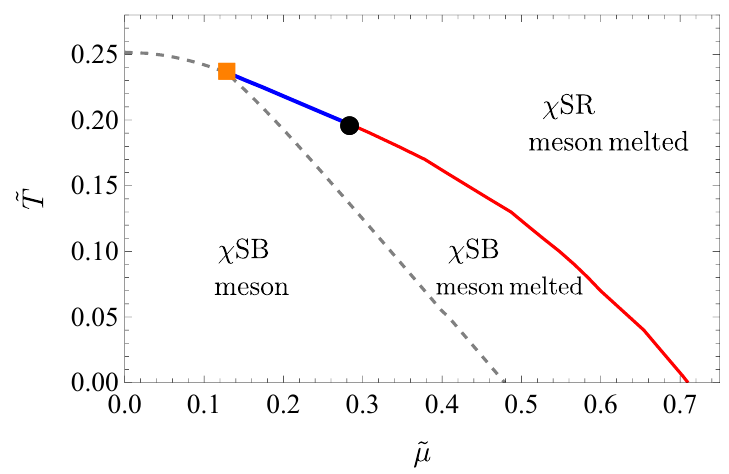
Figure 2 . The phase diagram for ˜ m = 0 . The black filled circle and orange filled square denote the TCP associated with the chiral phase transition and the critical point of the transition between the meson bound state and melted state, respectively. The blue and red solid lines denote the first- and second-order phase transition lines, respectively. The gray dashed line denotes the second-order phase transition line between the meson bound state and melted state, but we do not focus on this transition in this